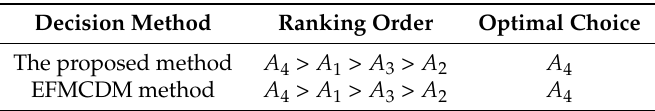
Table 13. Comparison of the proposed method with EFMCDM.